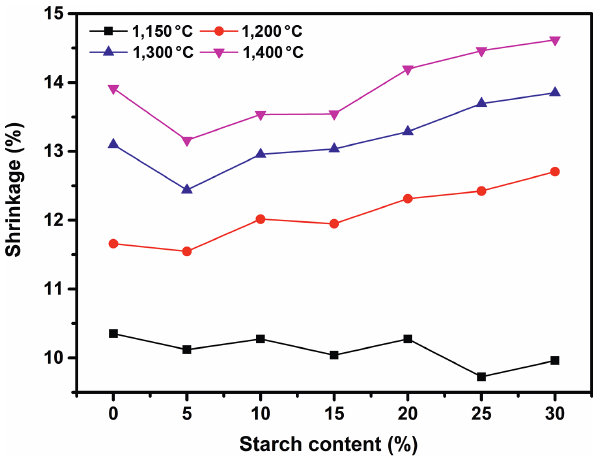
Figure 4: Comparison between shrinkage plots of samples with different starch contents.